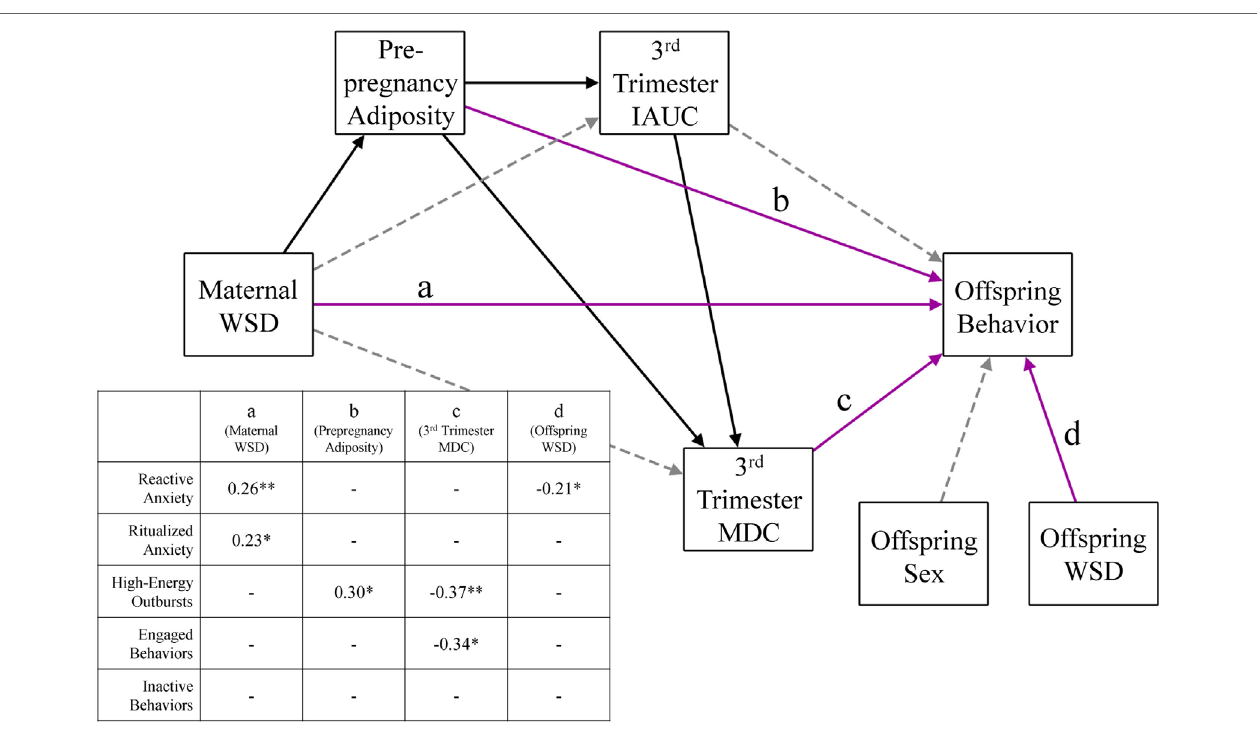
FigUre 1 | Perinatal environmental influences on offspring behavioral response. This figure presents the consolidated results of five different offspring behavior models, identical in every aspect except for the outcome behavior variable. Solid black lines were significant ( p < 0.05) in every behavior model and gray dashed lines were not significant in any model. Magenta lines (labeled a–d) were significant in some behavior models; the inset table details the significant direct effects of the corresponding model. Paths were also estimated from maternal age to prepregnancy adiposity, third trimester IAUC, and third trimester MDC and were consistent across all behavior models but were not depicted for ease of readability. WSD, Western-style diet; IAUC, insulin area under the curve. *p < 0.05 and ** p <